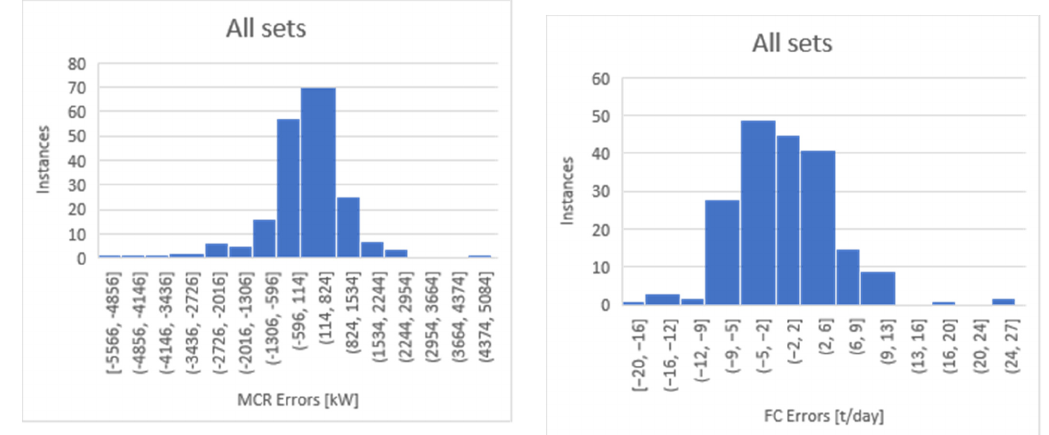
Figure 12. Error histograms of the artificial neural network to estimate the engine power (MCR) and fuel consumption (FC) of bulk carriers.